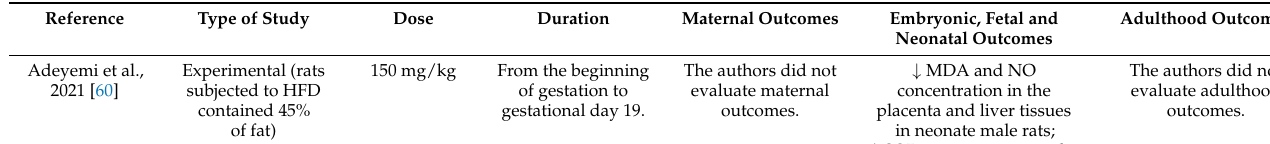
Table 3. Studies using quercetin in the treatment on HDF models inducing maternal overweight and dyslipidemia. The up arrow ↑ represents increase, down arrow ↓ represents